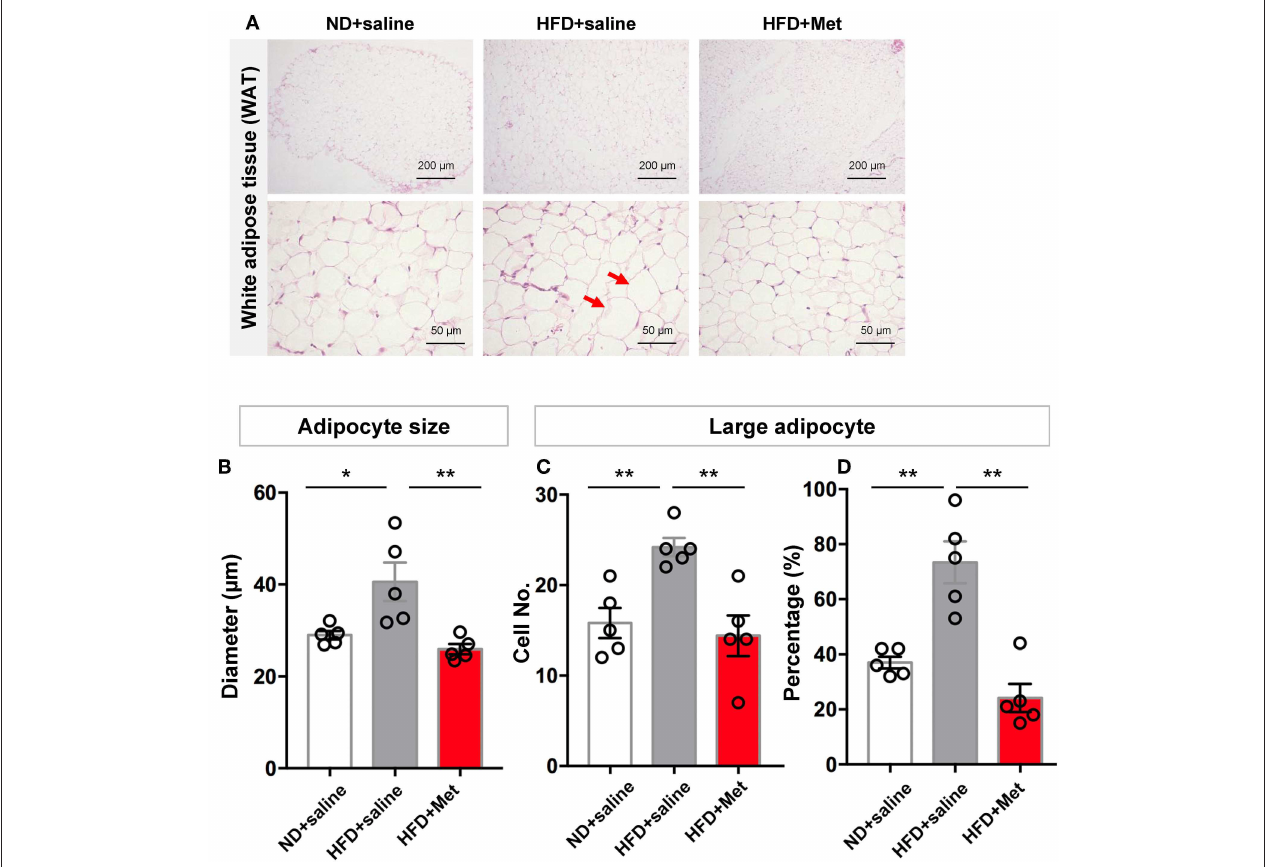
FIGURE 2 | Three-week HFD induced morphological change in white adipose tissue (WAT) and adipocyte size increase, which were alleviated by metformin co-treatment. (A) Representative H&E staining figures show that the changes in gain of body weight was accompanied by morphological change in the adipocytes of WAT (arrow heads indicate enlarged adipocytes; scale bars, 200 and 50 µ m, respectively); (B) HFD group had a larger averaged adipocyte size compared with ND, which was rescued by metformin co-treatment; (C,D) for large adipocytes (defined as cells with a diameter larger than the mean of all cells in ND group), HFD group showed higher value in cell number and percentage of large adipocytes. This increase was also rescued by metformin co-treatment. For (A–D) , n = 5 per group; for (B–D) , data were presented as mean ± SEM, each dot represents one mouse; One-way ANOVA with Tukey’s test, * p < 0.05, ** p <